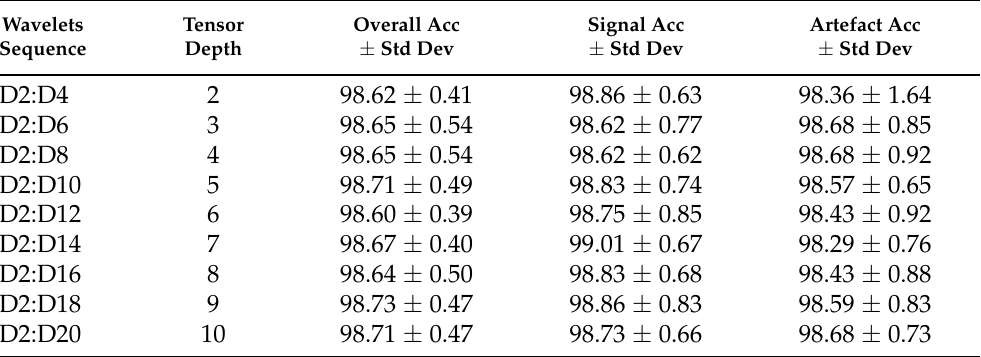
Table 6. CNN model performance for various wavelet transformations applied to input data (deep tensors). Results have been estimated using repeated k-fold validation (5 rounds with 5 folds each).